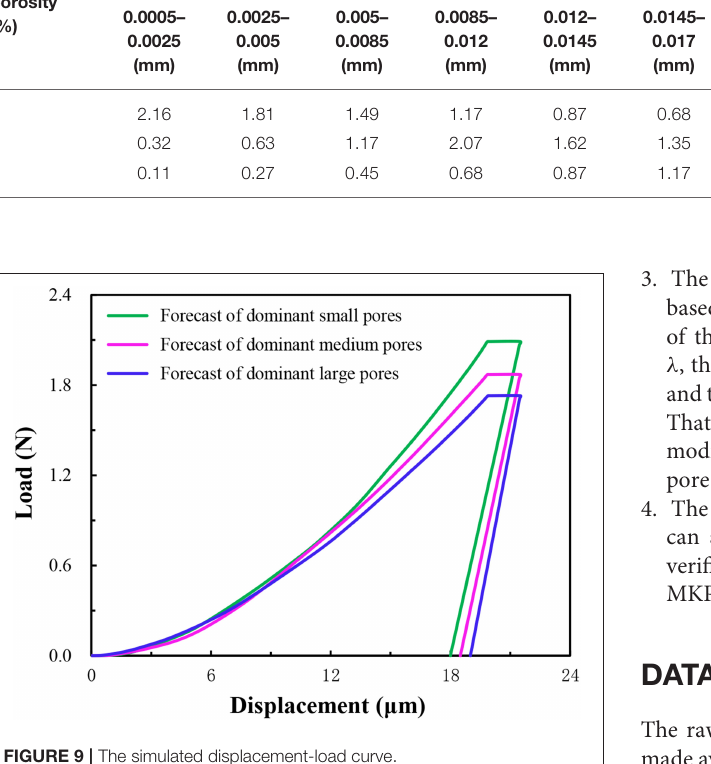
TABLE 6 | The prediction of the effect of pore distribution. Total porosity